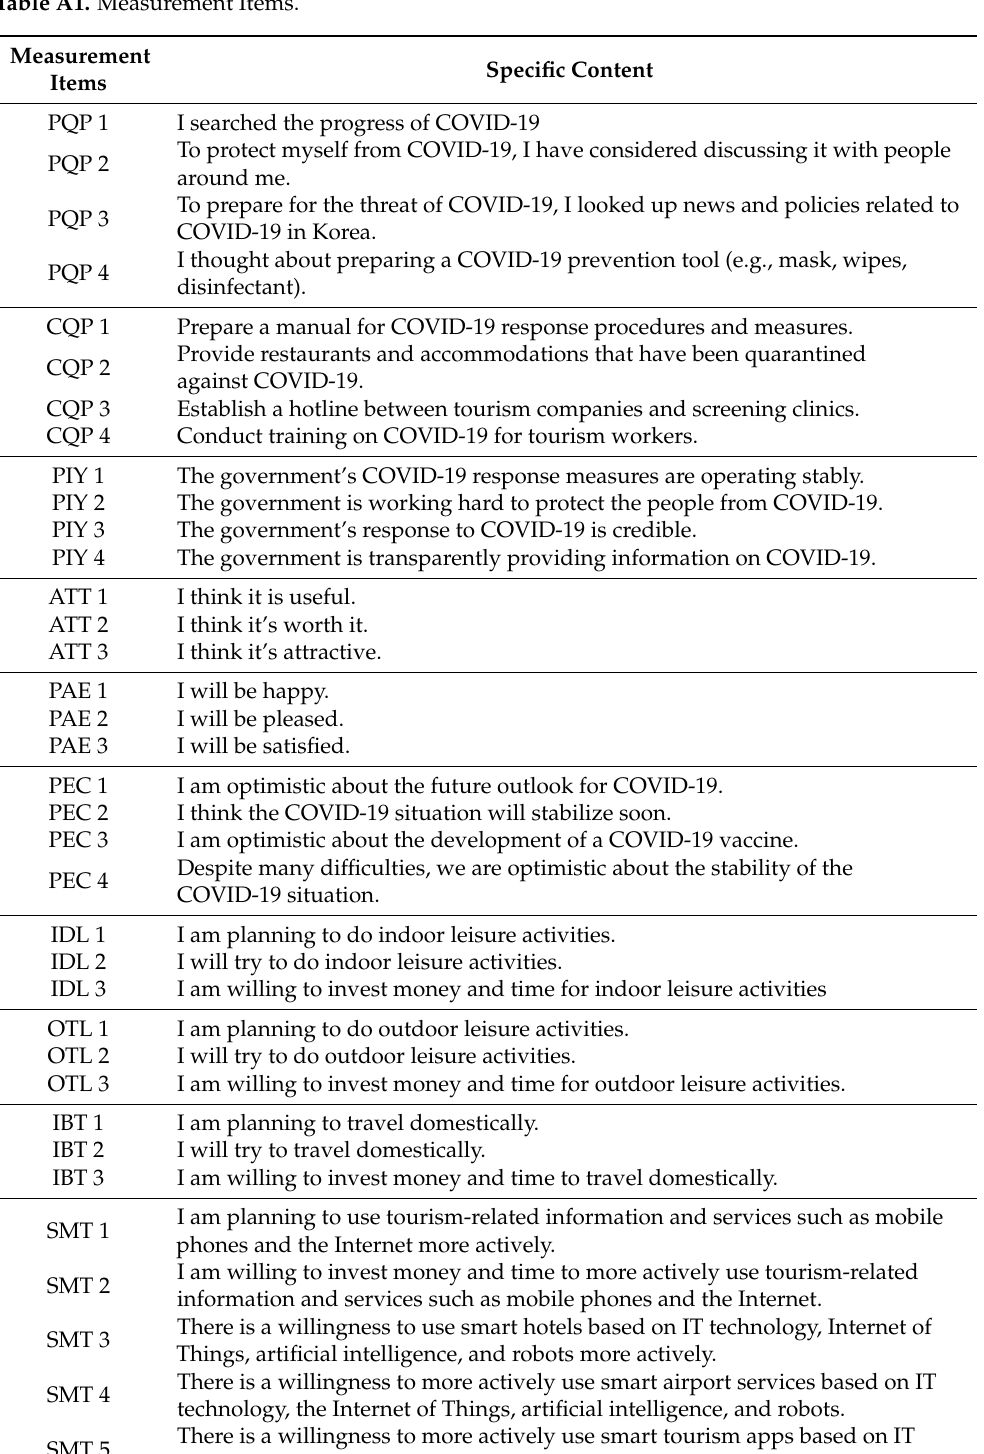
Table A1. Measurement